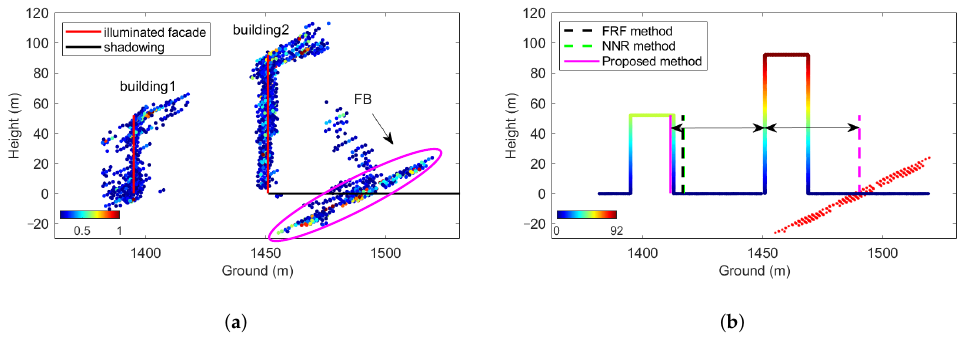
Figure 17. Results of Slice 1 in Experiment 2. ( a ) TomoSAR point cloud. The colormap indicates the normalized scattering intensity. ( b ) The reconstruction results of the back of building 1, where the line colored by height indicates the reference true